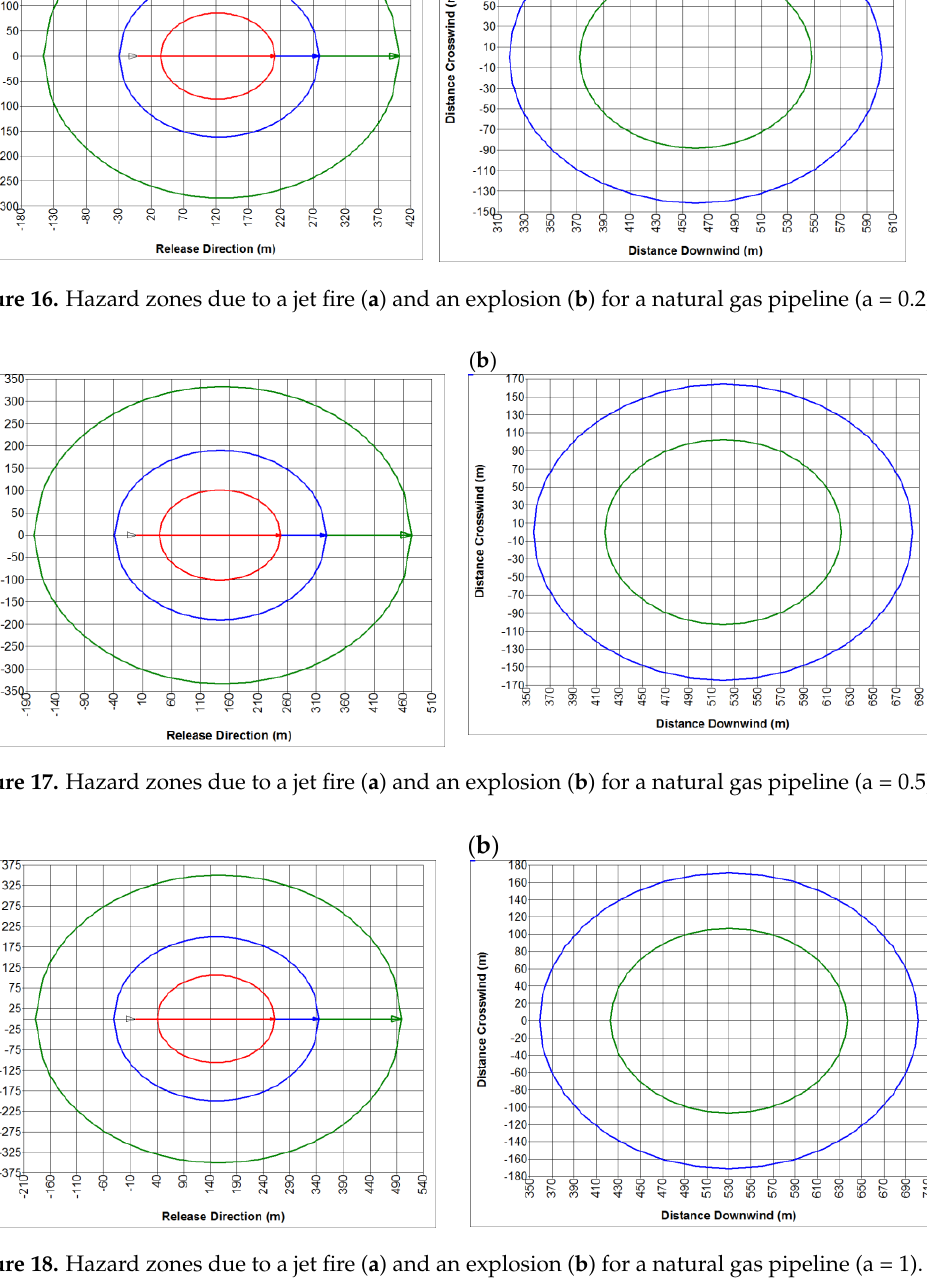
Figure 18. Hazard zones due to a jet fire ( a ) and an explosion ( b ) for a natural gas pipeline (a = 1)